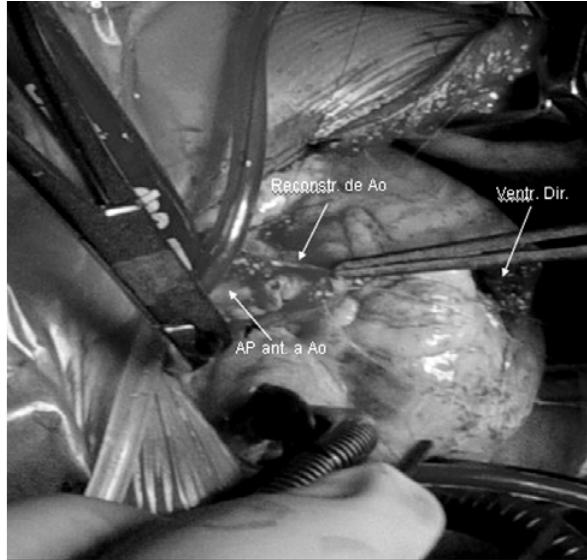
Fig. 5 - Fotografia cirúrgica. Observa-se a AP anteriorizada em relação à Ao (manobra de Lecompte) e Ao sendo reconstruída, mediante anastomose término-terminal. Ventriculotomia direita (Ventr.